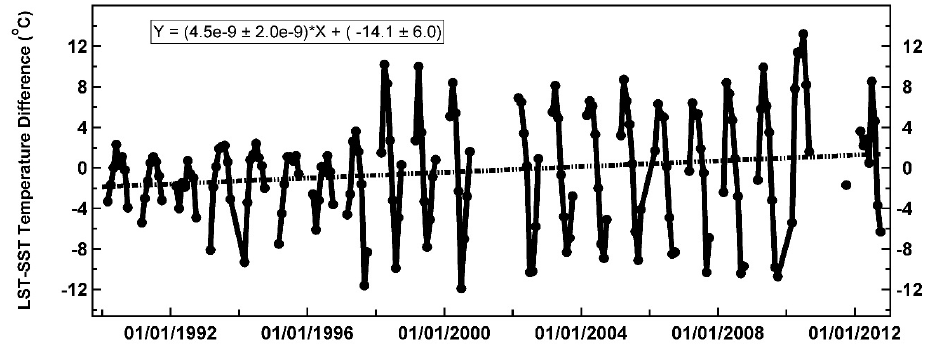
Figure 10. Time series of land surface temperature (LST) minus sea surface temperature (SST) for the Houston area.